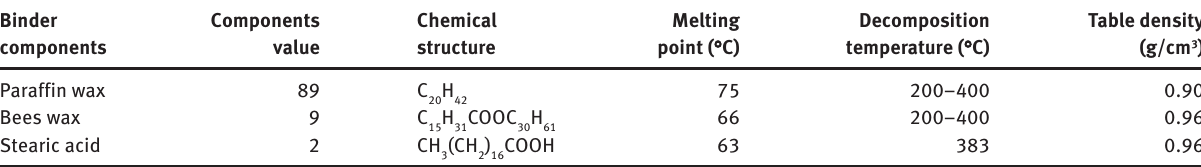
Table 1 The characteristics of the binder components. Binder